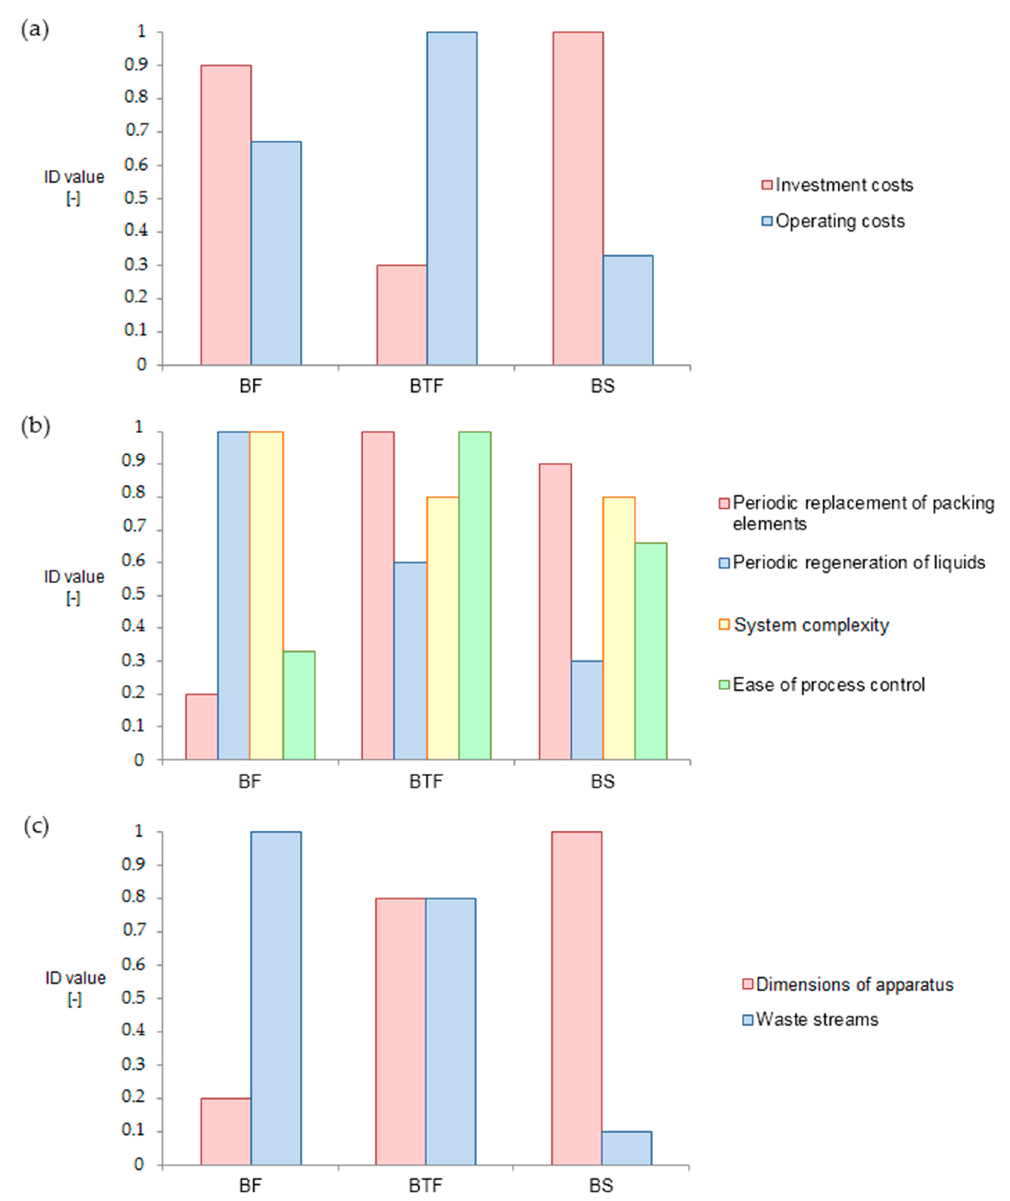
Figure 3. Diagrams presenting indicator values for each sub-criterion: ( a ) diagram of criterion 2. ( b ) diagram of criterion 3. ( c ) diagram of criterion 4.